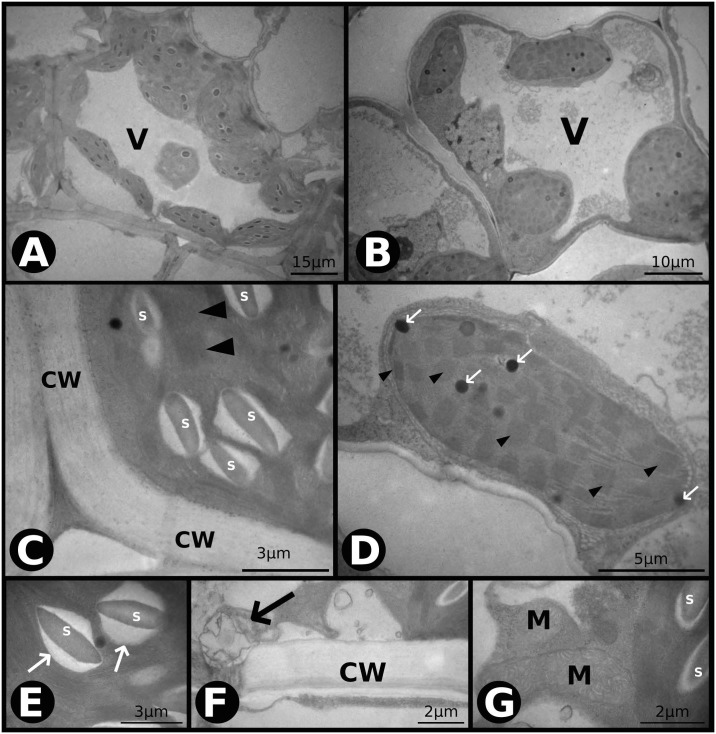
Transmission electron microscopy (TEM) photomicrographs of leaves of P. maximum under ambient [CO2] and air warming (aCeT).(A) Overviews of a bundle sheath cell (BSC). V–vacuole. (B) Overview of a mesophyll cell (MC). V–vacuole. (C) Chloroplast of a BSC with spaces between the starch grains and chloroplasts and conserved thylakoid membranes (indicated by arrowheads). CW–cell wall, S–starch. (D) Overview of a chloroplast of a MC with plastoglobuli (indicated by arrows) and conserved thylakoid membranes (indicated by arrowheads). (E) Thylakoid membrane detail of the chloroplast of a BSC and spaces between the starch grains and chloroplasts (indicated by arrows). S–starch. (F) Cytoplasm retraction in a BSC and traffic of vacuoles with an MC through plasmodesmata (indicated by an arrow). CW–cell wall. (G) Association of mitochondria and chloroplasts of a BSC. S–starch, M–mitochondria.